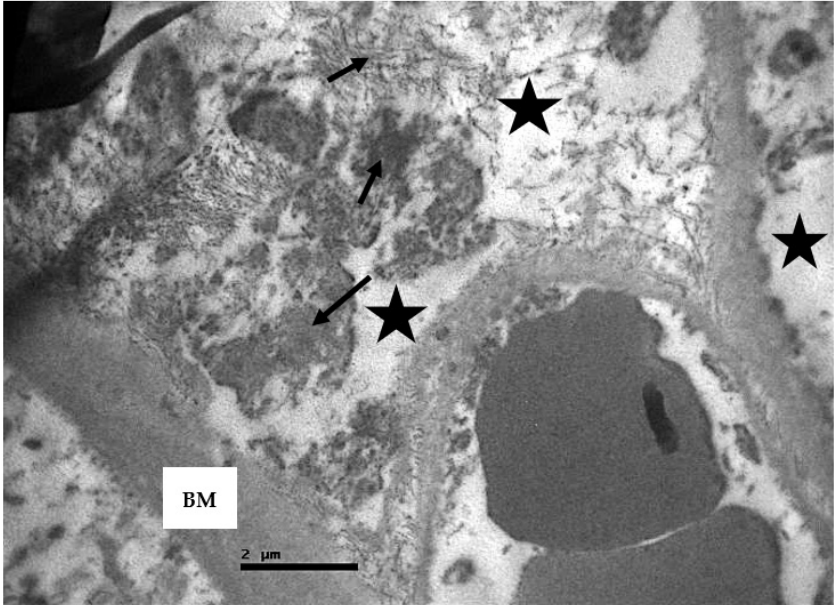
Figure 15. Connective tissue of non-resuscitated swine sample that showed fibrosis (black arrows) and edema (black stars). The basement membrane of the cuboidal epithelium appears thickened (BM).